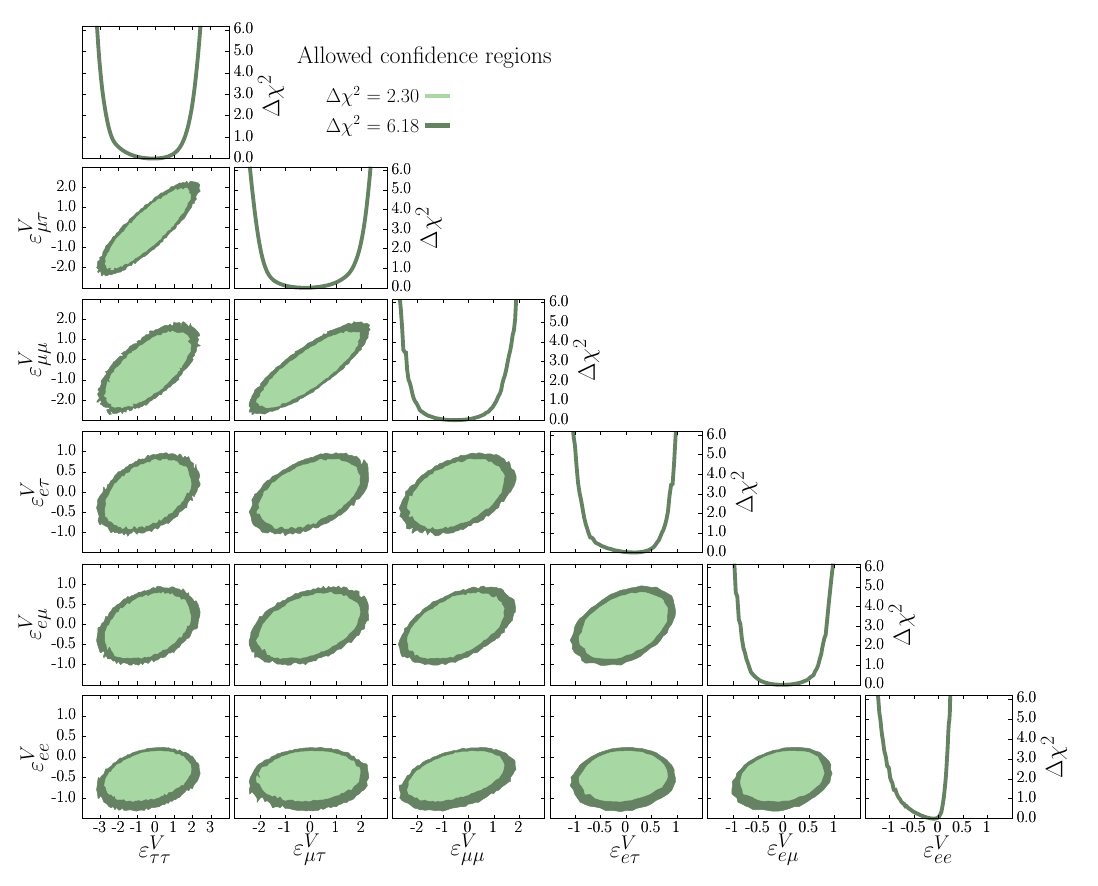
Figure 4 . Same as figure 3, but for vector NSI with electrons ( ε L